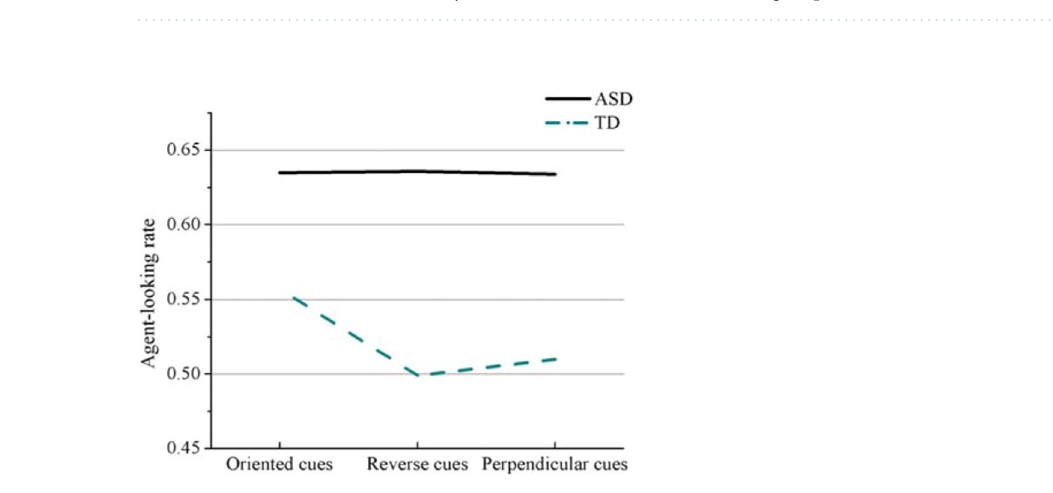
Figure 5. Agent-looking rate of the two groups for the three types of gaze